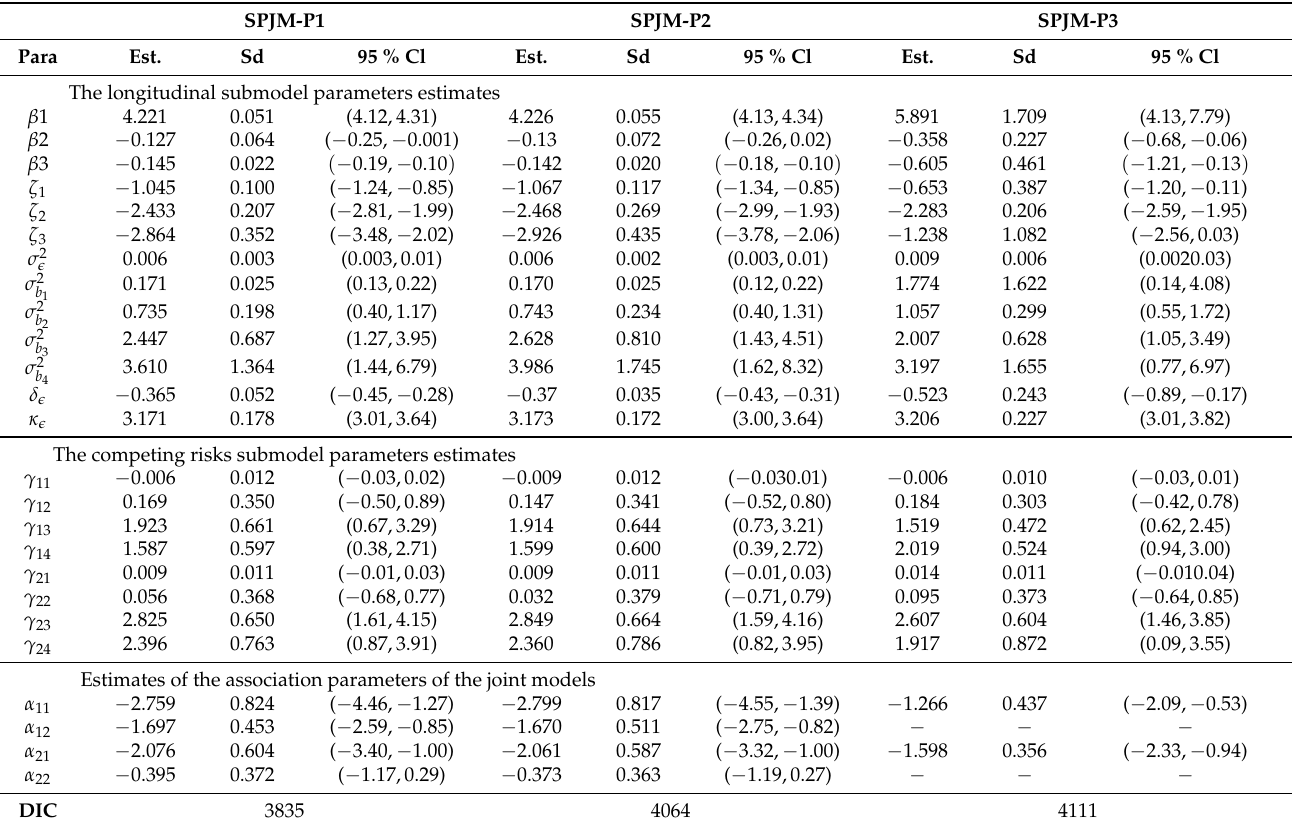
Table 2. The posterior mean estimates (Est), standard deviation (Sd) and 95% credible interval (CI) for the parameters from the proposed joint models with different